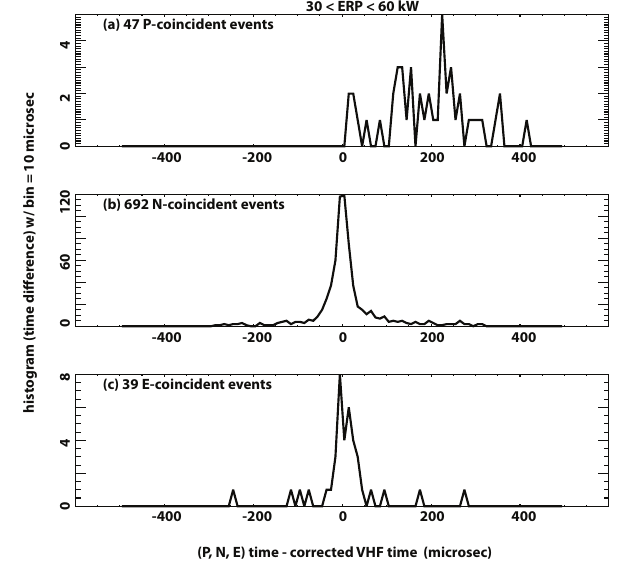
Fig. 8. Histograms of time differences between three coincidence- source trigger times, minus propagation-corrected FORTE VHF trigger times. VHF events are limited to the lowest-power: ERP < 30kW. Histogram uses a 10-µs bin. (a) Coincidence with com- bined optical photometer and imager triggers. (b) Coincidence with NLDN triggers. (c) Coincidence with LASA triggers.